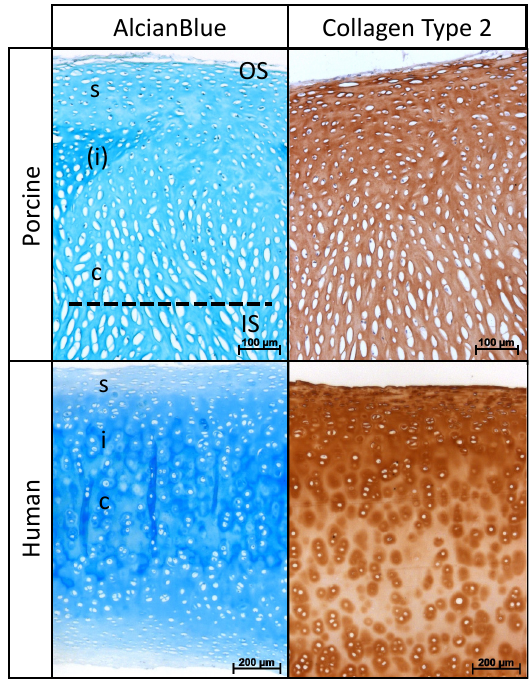
Figure 1. Histological organization of DPNC. Porcine and human nasal cartilage show similar